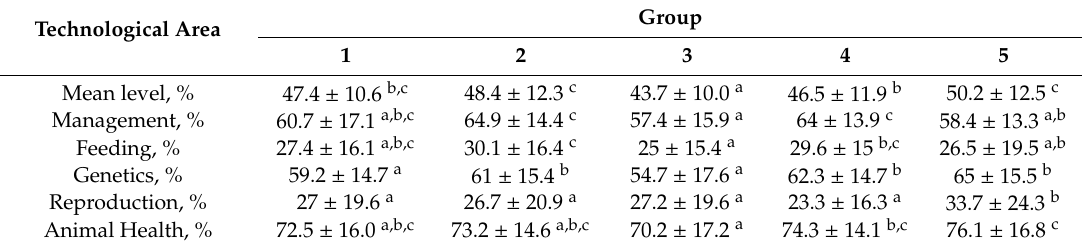
Table 5. Technological characterization for each group of smallholder dual-purpose